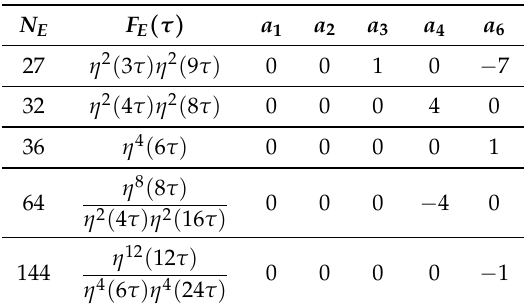
Table 1. Table of five elliptic